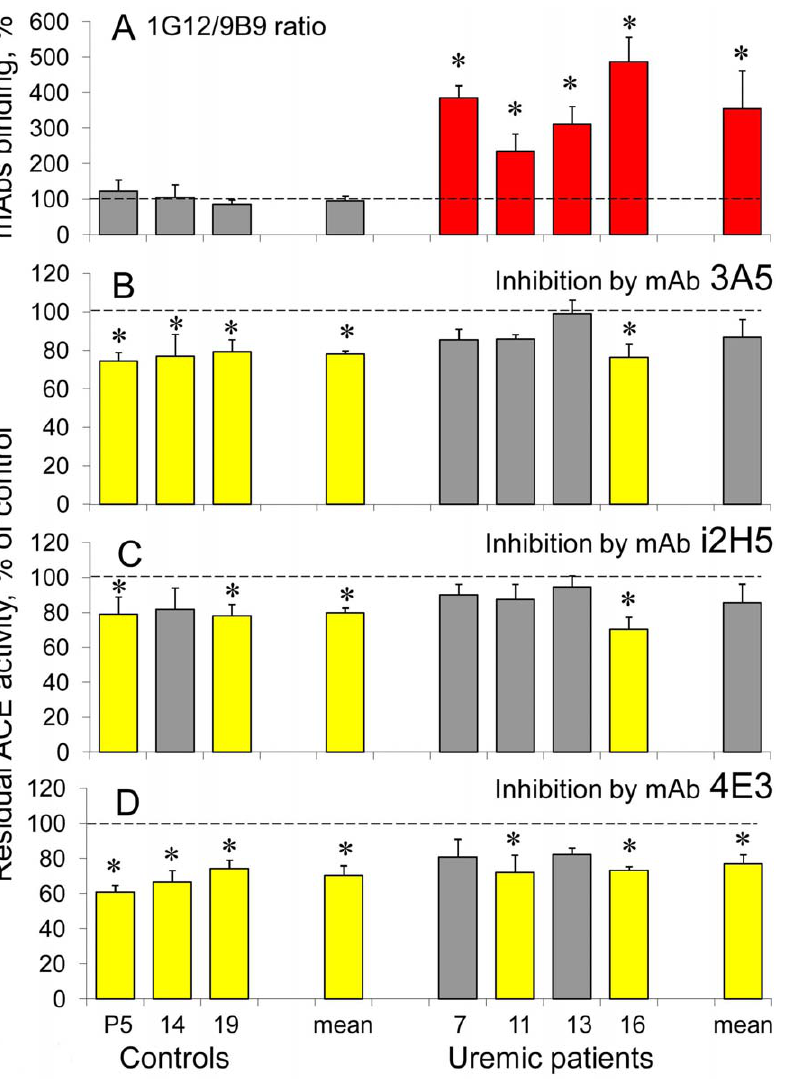
Figure 6. Effect of anti-catalytic mAbs on plasma ACE in uremia. A . The ratio of ACE activities precipitated from the citrated plasma of uremic patients with high 1G12/9B9 ratio and normal ZPHL/HHL ratio and from healthy controls (P5– pooled citrated plasma, # 14 and # 19– individual plasmas) by mAbs 1G12 and 9B9 (1G12/9B9 ratio. Grey bars – healthy controls; red bars – uremic patients with high 1G12/9B9 ratio with p , 0.05 in comparison with mean value. B-D . Effect of anti-catalytic mAbs on ACE activity. The effects of anti-N domain mAbs 3A5 and i2H5 [42] were determined with ZPHL as a substrate. The effect of anti-C domain mAb 4E3 [27] was determined with HHL as a substrate. Data are presented as a residual ACE activity after incubation of tested mAbs (10 m g/ml) with citrated plasma (diluted 5-fold). Grey bars – ACE inhibition less than 20%,